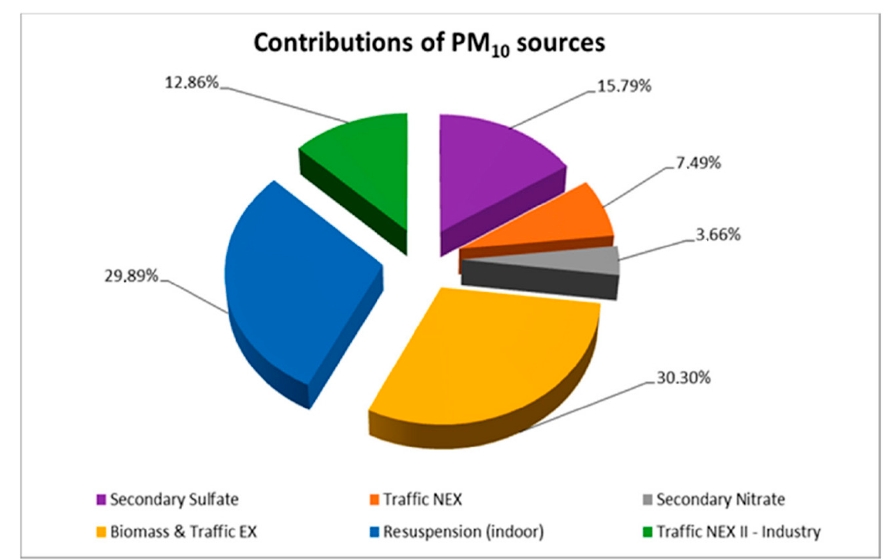
Figure 6. Contribution percentages of each factor to the total mass of PM 10.